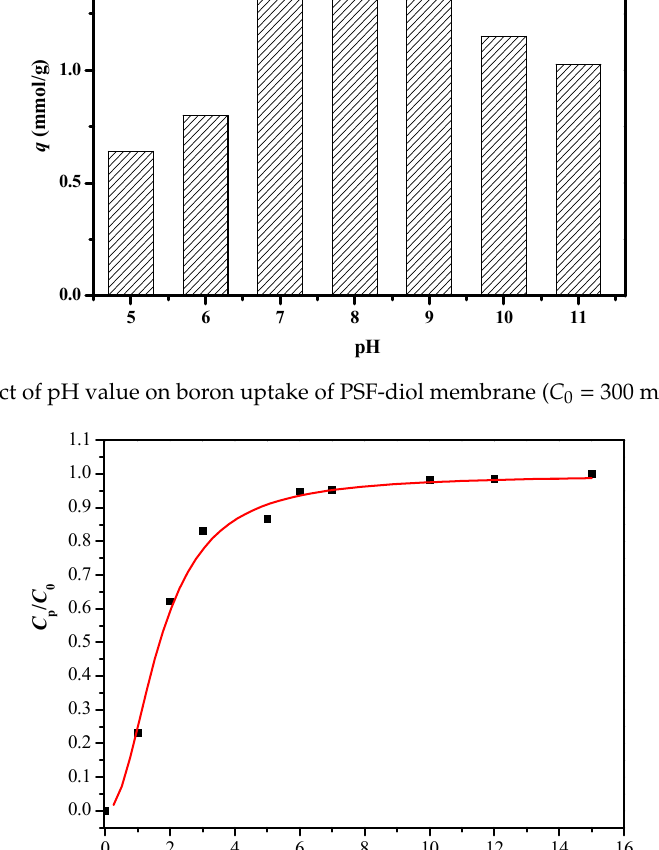
Figure 13. Effect of pH value on boron uptake of PSF-diol membrane ( C 0 = 300 mg/L, T = 25 °C).